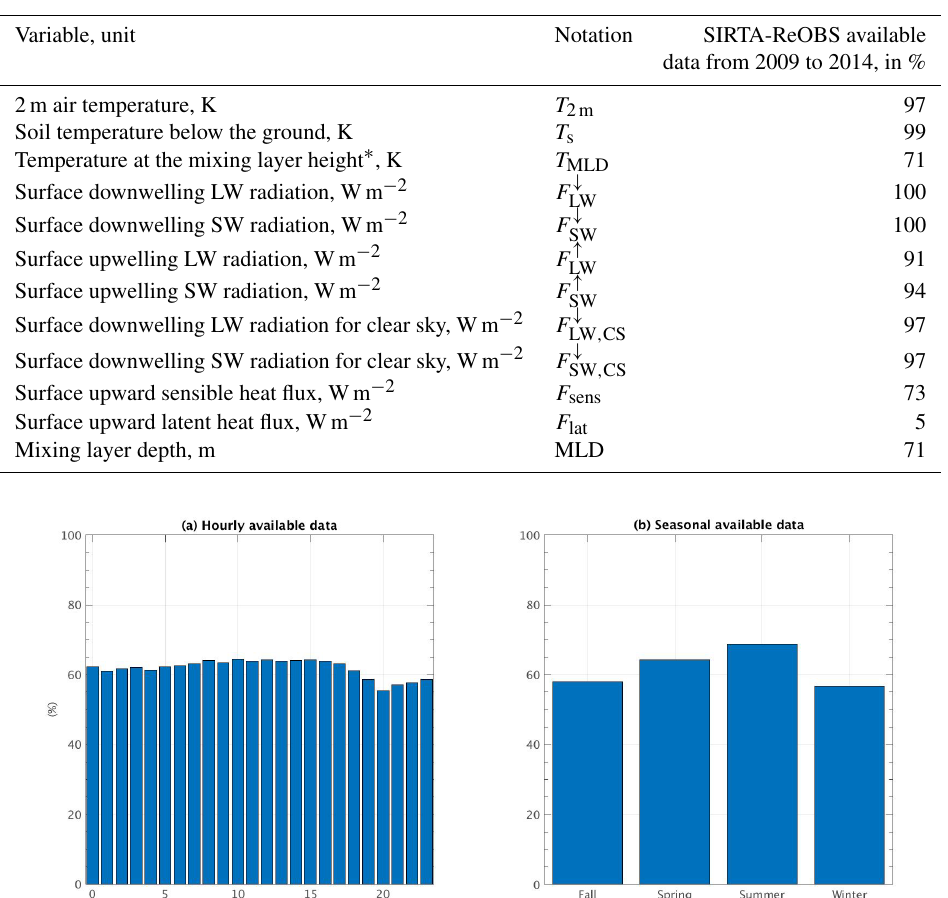
Table 1. Variables available in the SIRTA-ReOBS dataset used as inputs in the temperature variation model. ∗ T MLD is also estimated using the ERA5 dataset.